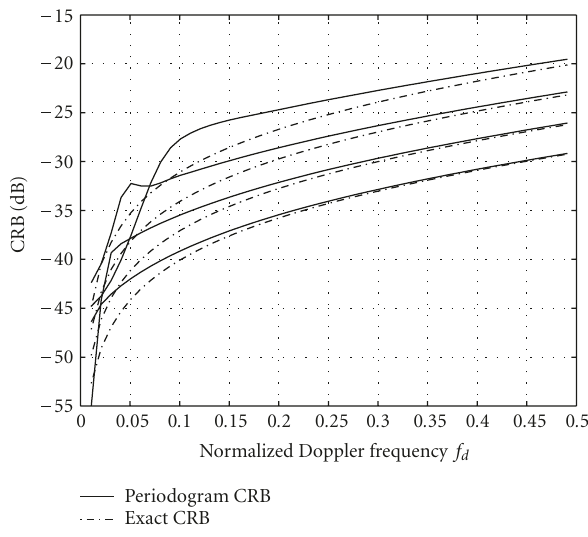
Figure 2: The periodogram-based asymptotic CRB and exact CRB with respect to f d . The results shown are for di ff erent values of N . N = 32,64,128,256, and κ = 0. β = 10dB.